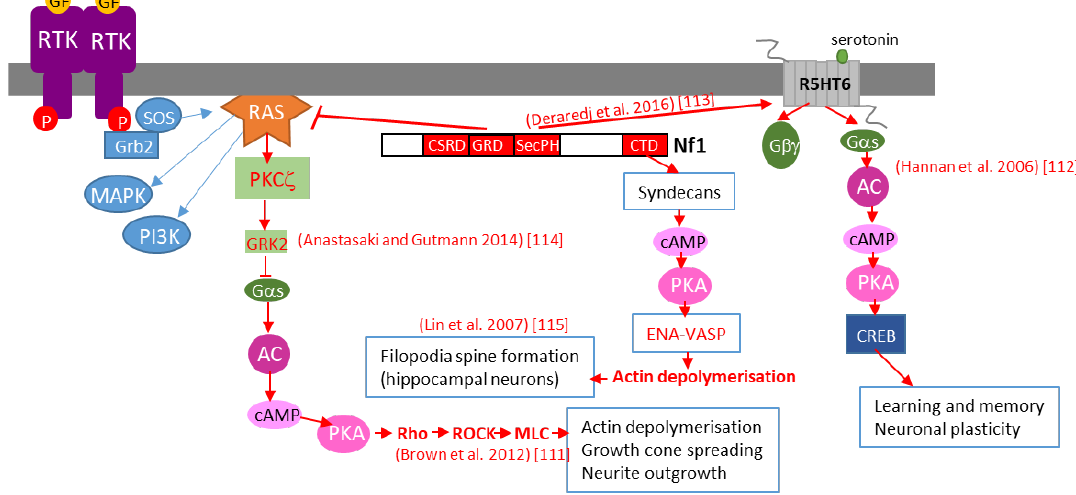
Figure 9. Schematic representation of various mechanisms of neurofibromin-mediated cAMP regulation. GF: growth factor, RTK: tyrosine kinase receptor, AC: adenylate cyclase, CREB: cAMP response element-binding protein, MAPK: mitogen-activated protein kinase, PI3K: phosphoinositide 3-kinase, SOS: son of sevenless, Grb2: growth factor receptor-bound protein 2.